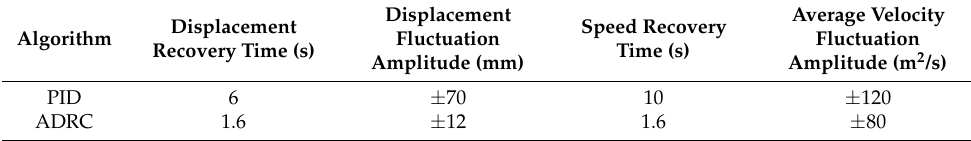
Table 4. Time domain index under random lateral